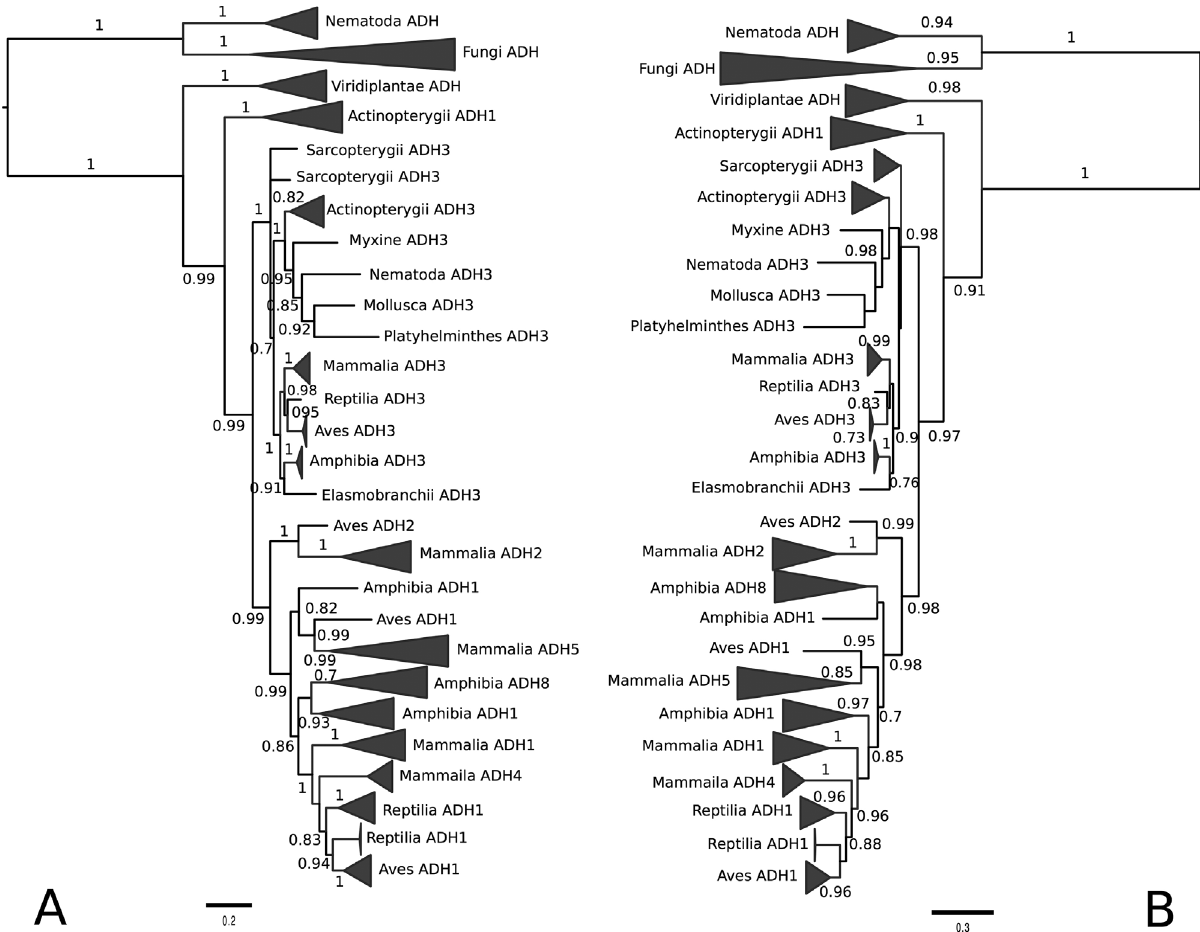
Figure 1 - Evolutionary history of alcohol dehydrogenase proteins from plants, fungi and animals. A. Bayesian Inference; B. Maximum Likelihood. Numbers represent posterior probability and aLRT non-parametric branch support, respectively. Only values higher than 0.7 are shown. Scale bar indi- cates levels of sequence